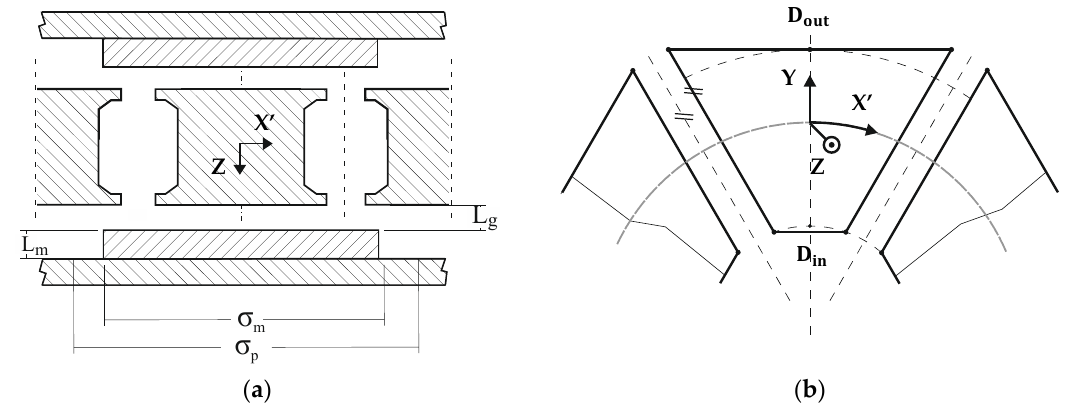
Figure 2. ( a ) Mapping of the AF machine on X’Z plane as linear machine as described in [11]. ( b ) Simplified yokeless stator cores shape illustration with parallel planes slots. The rotor had a shape based on two arcs with diameters D out and D in .